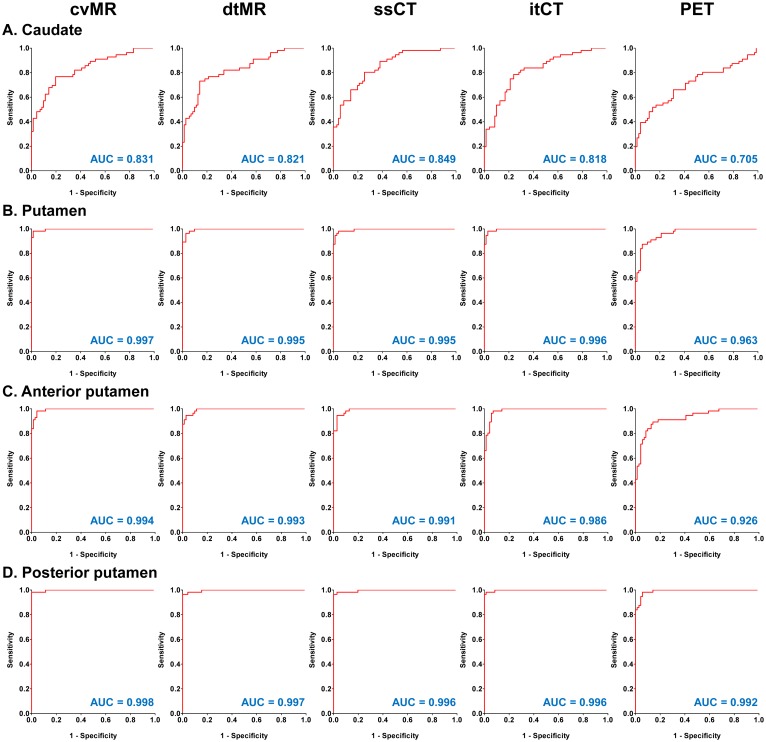
Receiver-operator characteristic (ROC) curve analysis of striatal SUVR values derived from five different spatial normalization methods for the separation of controls and Parkinson’s disease (PD) patients.The area under the curve (AUC) values are presented in the right lower corner of each graph. Putaminal SUVR values derived from all five spatial normalization methods very effectively discriminated PD patients. Both CT-guided methods show similar performance to both MR-guided methods. However, the PET-guided method was less effective than the other four structure-guided spatial normalization methods. Abbreviations: cvMR = MR-guided spatial normalization with conventional normalization tool, dtMR = MR-guided spatial normalization with DARTEL toolbox, ssCT = skull-stripped CT-guided spatial normalization, itCT = intensity transformed CT-guided spatial normalization, PET = PET-guided spatial normalization.